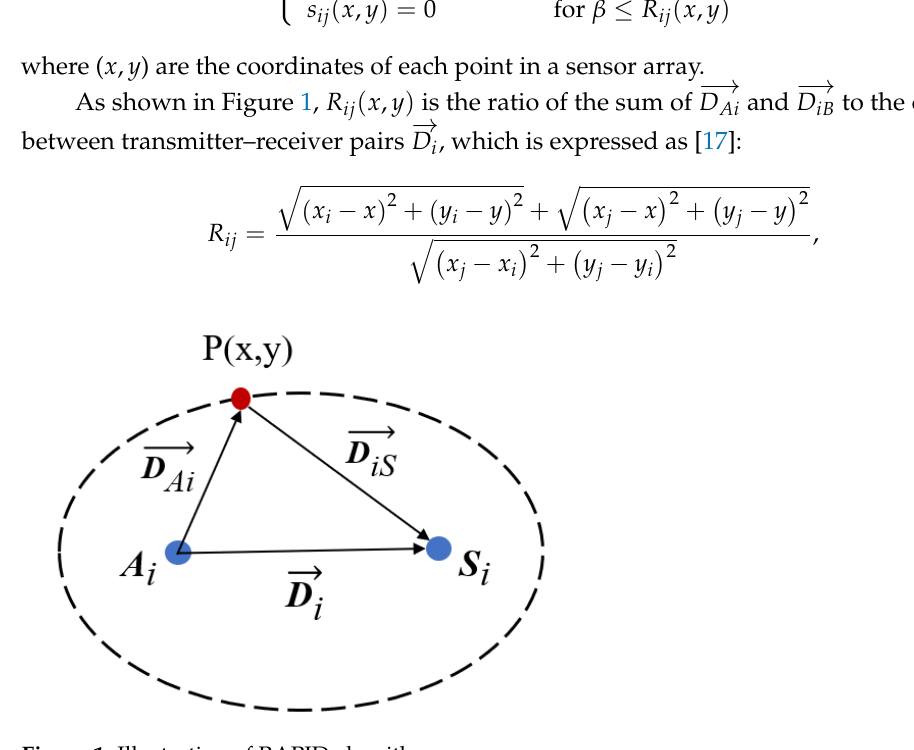
Figure 1. Illustration of RAPID